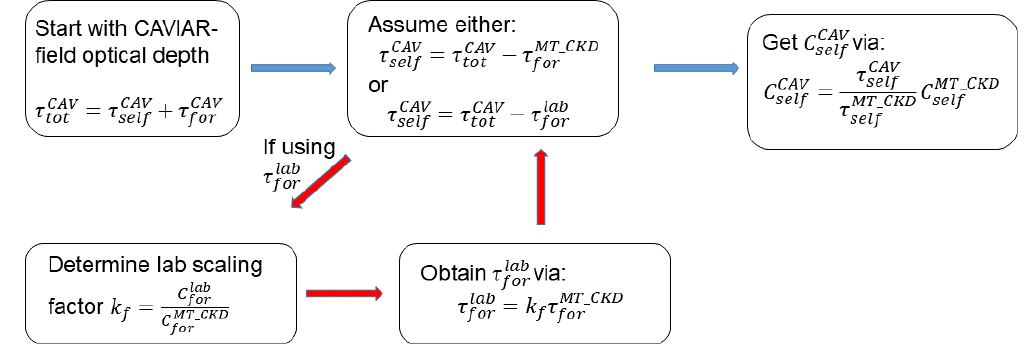
Figure 11. Derivation process of the self-continuum absorption cross section implied by the FTS optical depth. This process can be done for the foreign continuum, in which case all references to the self-continuum in the figure apply to the foreign continuum and vice versa.